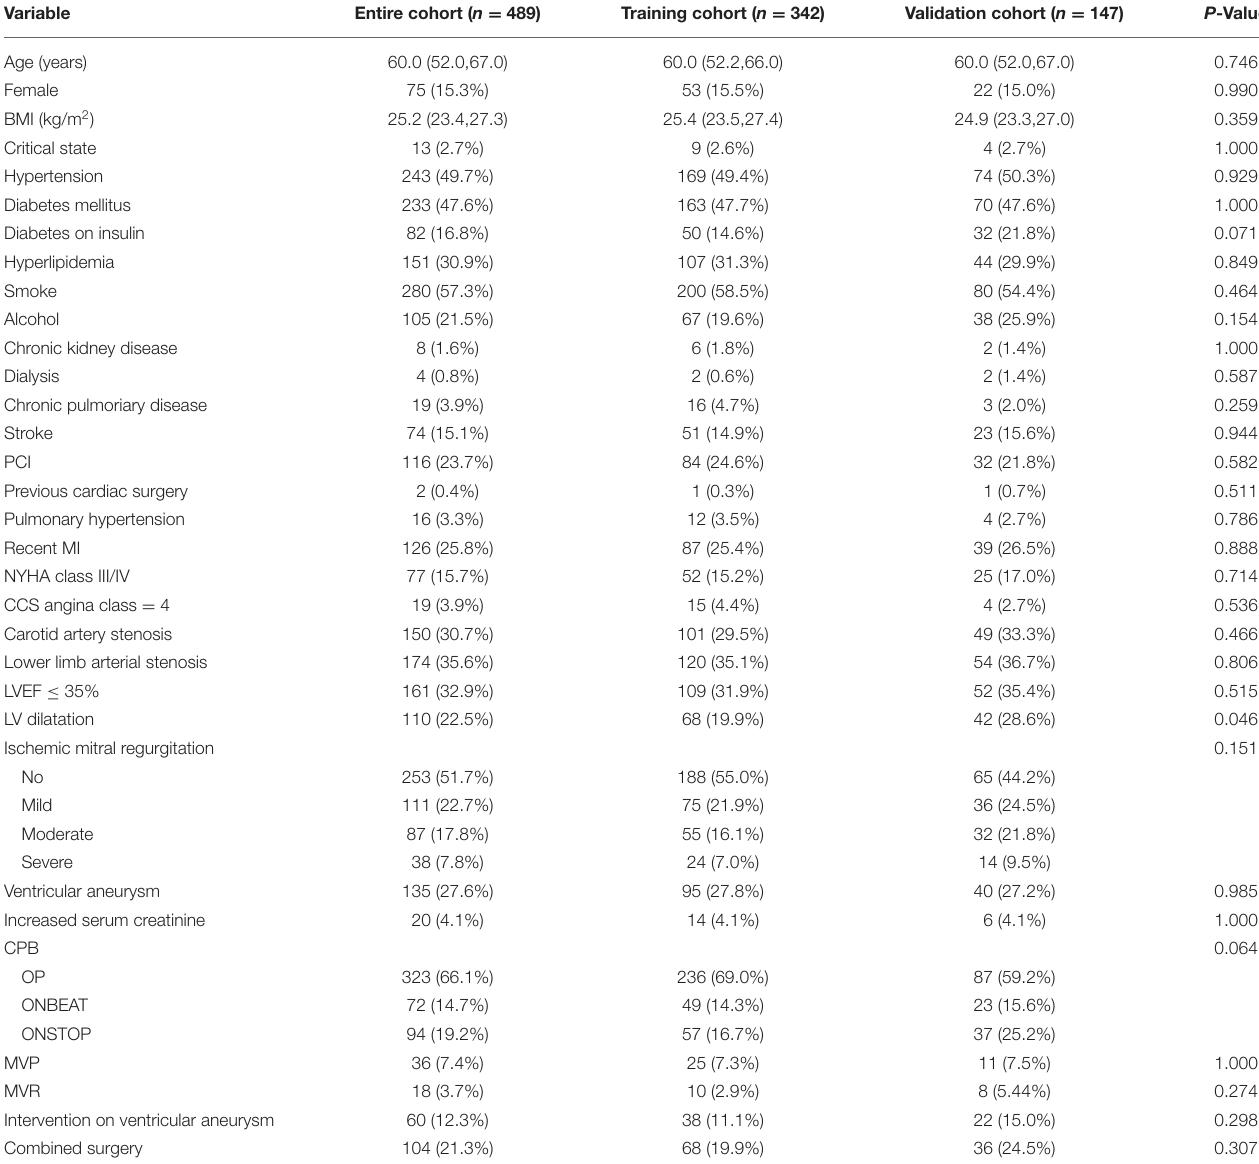
TABLE 1 | Baseline characteristics of